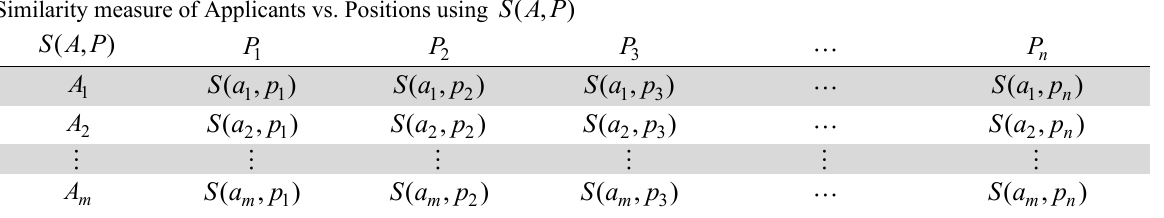
Similarity measure of Applicants vs. Positions